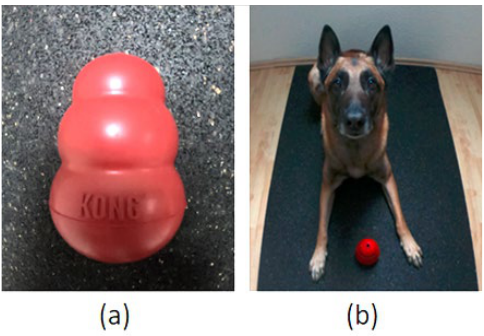
Figure 1. ( a ) A Kong™. ( b ) Start position for the Kong™ Test: The dog lies down with the dog’s body evenly and symmetrically aligned; the Kong™ is put between the dog’s front paws.